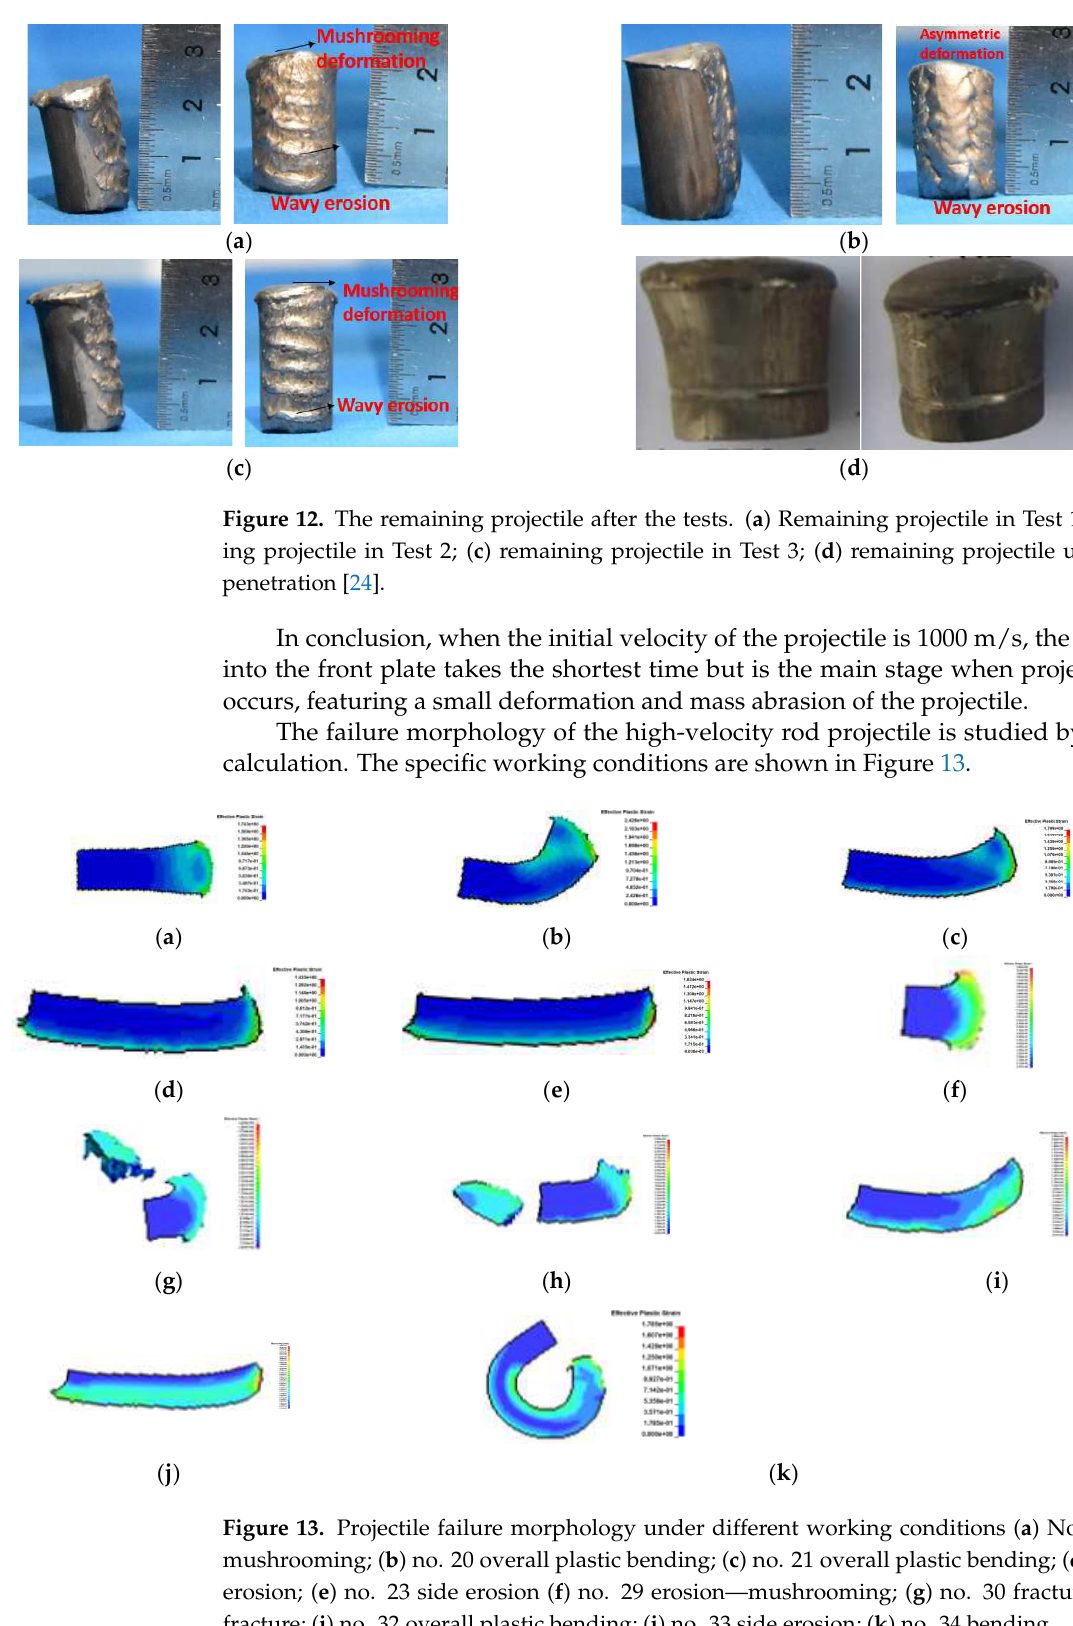
an overturning moment is generated on the projectile under asymmetric loads, leading to the bending stress on the cross-section of the projectile; the critical section of the projectile reaches the yield limit under the combined action of axial compressive stress and bending